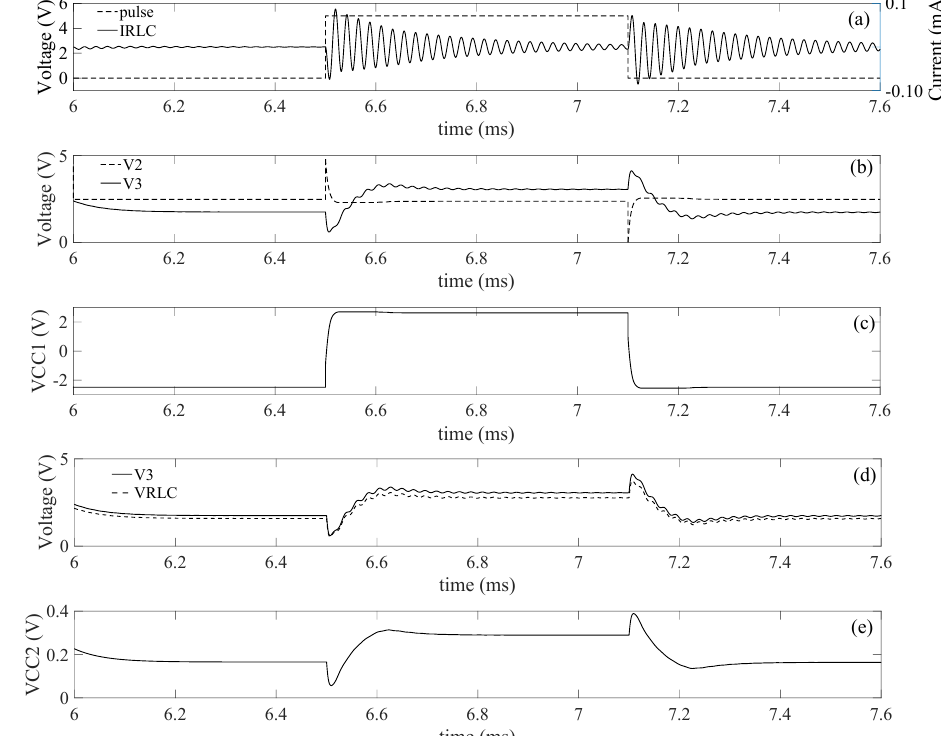
Figure 17. Simulation of the bidirectional amplifier in actuation mode using the LV (low voltage) model AMS-350nm model. ( a ) Input pulse and current through the RLC elements; ( b ) Input and output signals of the bidirectional amplifier; ( c ) Voltage across the input coupling capacitor; ( d ) Comparison between the output signal of the bidirectional amplifier and the signal across the transducer model; ( e ) Voltage signal across the coupling capacitor C C 2 . L m = 50 mH, R b = 300 Ω , C s = 300 pF, C E = 2 nF, C C 1 = 1 nF, C C 2 = 22